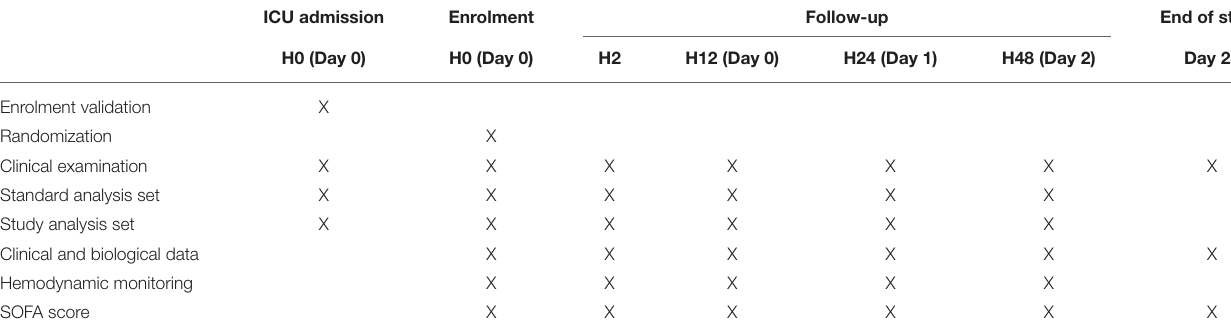
TABLE 1 | Protocol timeline.